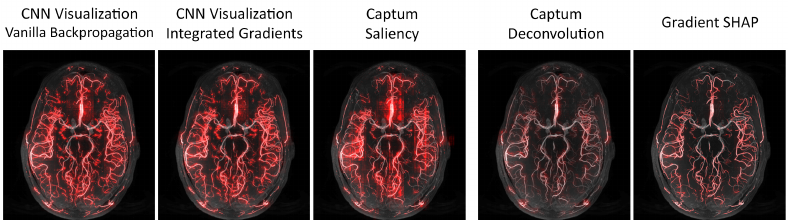
Figure 6. Some of the similar interpretability results of the U-Net MSS Deformation model. The higher the intensity of red, the higher the concentration of the focus of the network. The results of CNN Visualization Vanilla Backpropagation, CNN Visualization Integrated Gradients, and Captum Saliency show similar focus areas: on the anterior, posterior, right, and left regions of the brain. Captum Deconvolution and Gradient SHAP emphasise specifically on the cerebral artery itself, not the whole